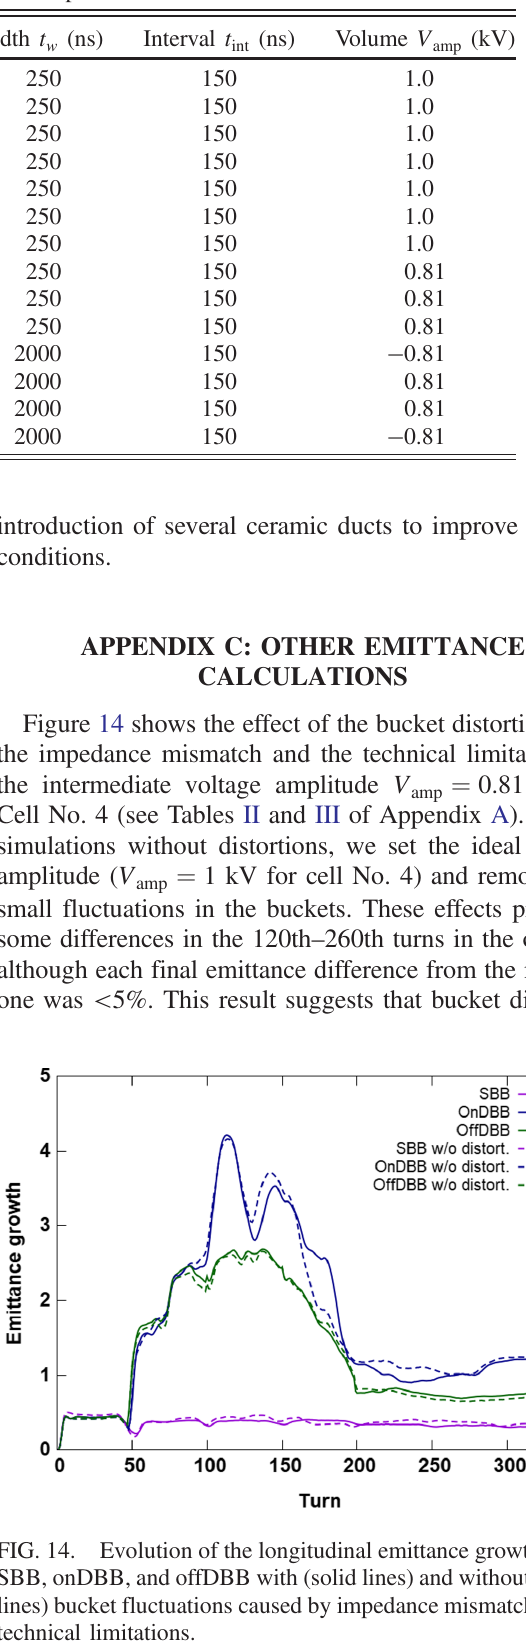
TABLE III. Trigger timings and amplitudes of the acceleration pulse in the offDBB.